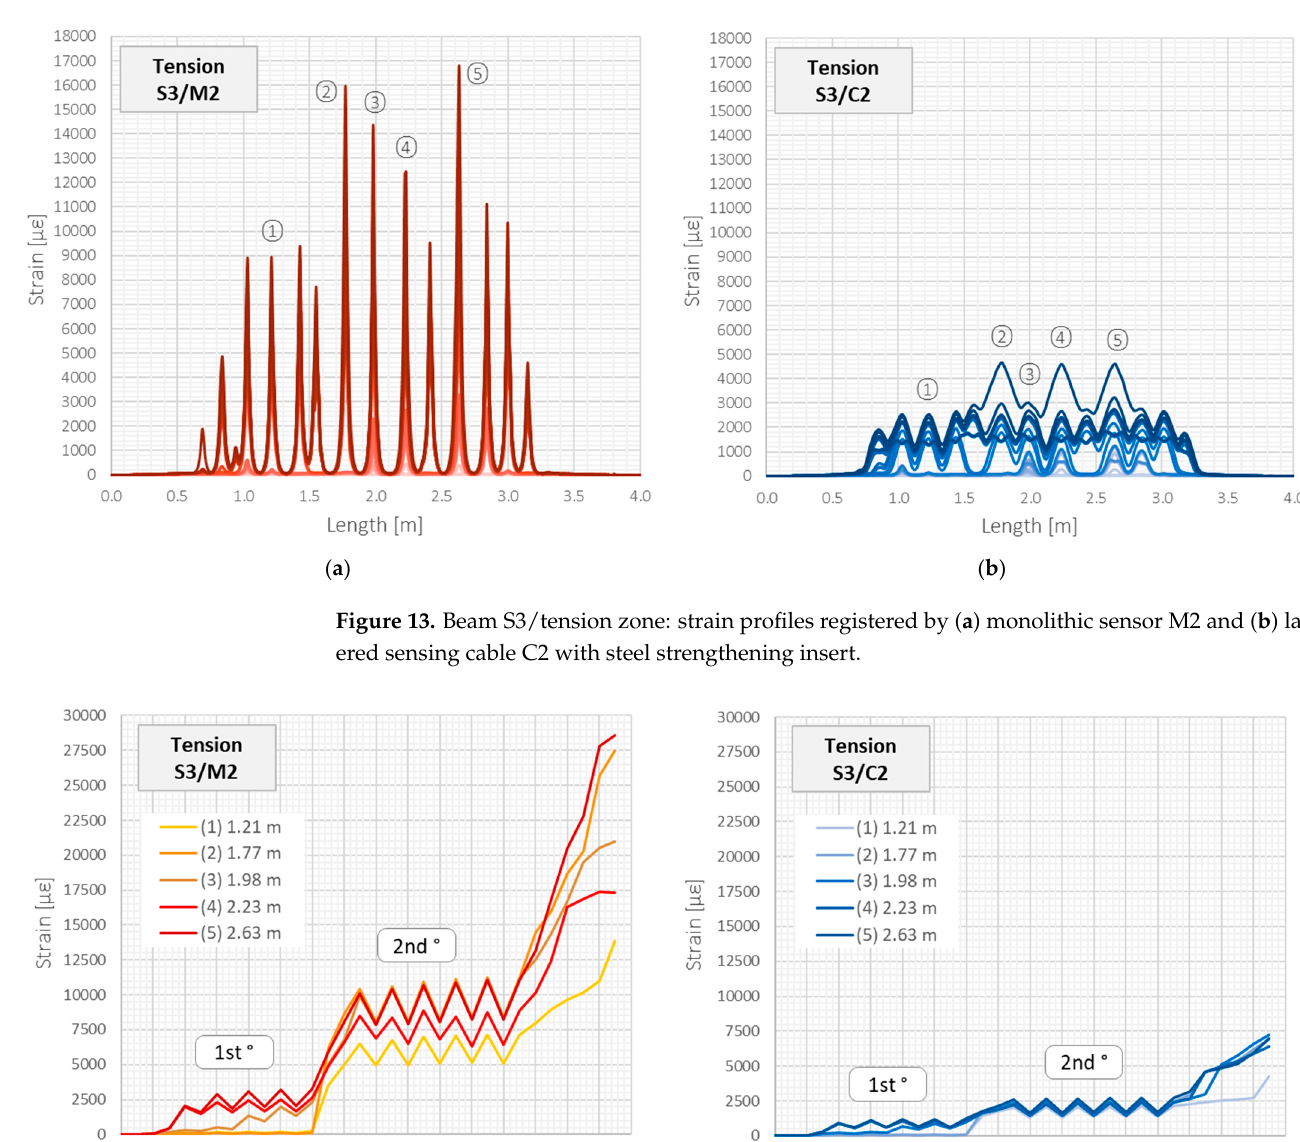
Figure 14. Beam S3/tension zone: crack-induced strain peaks over subsequent load steps registered by ( a ) monolithic sensor M2 and ( b ) layered sensing cable C2 with steel strengthening insert.